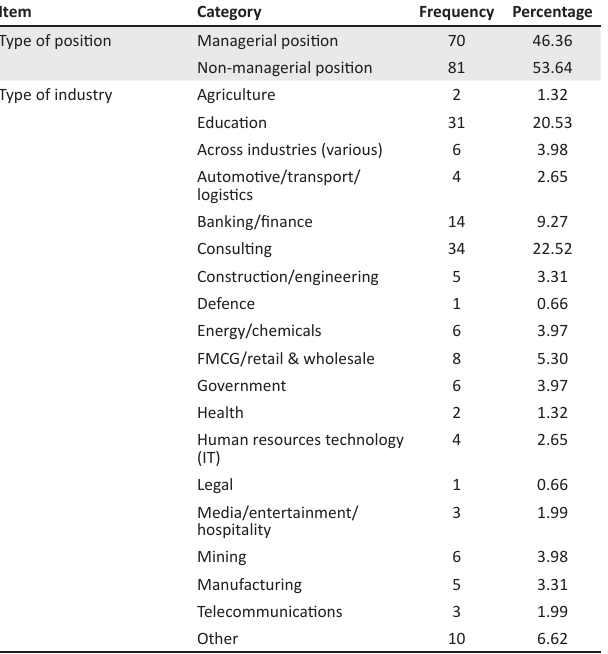
TABLE 1: (Continues...) Characteristics of the participants.